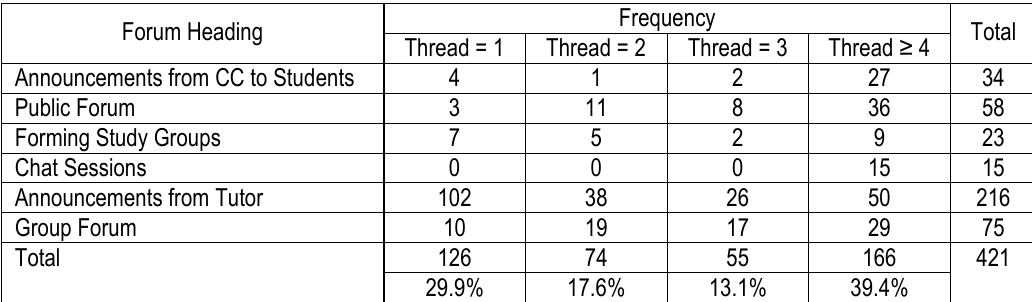
Table 8. WOU LMS: Thread Levels of